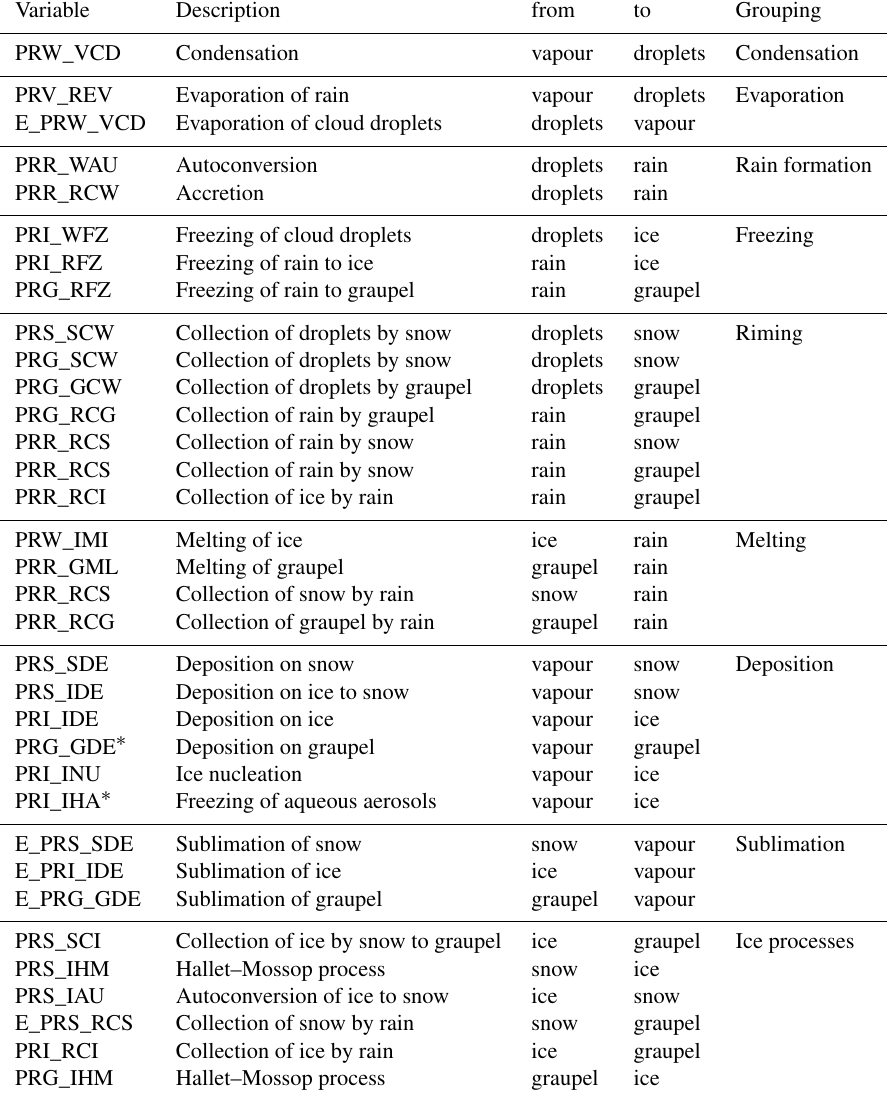
Table B2. Mass transfer process rates for the Thompson microphysics scheme (Thompson et al., 2008). ∗ denotes processes that are imple- mented but disabled in the microphysics